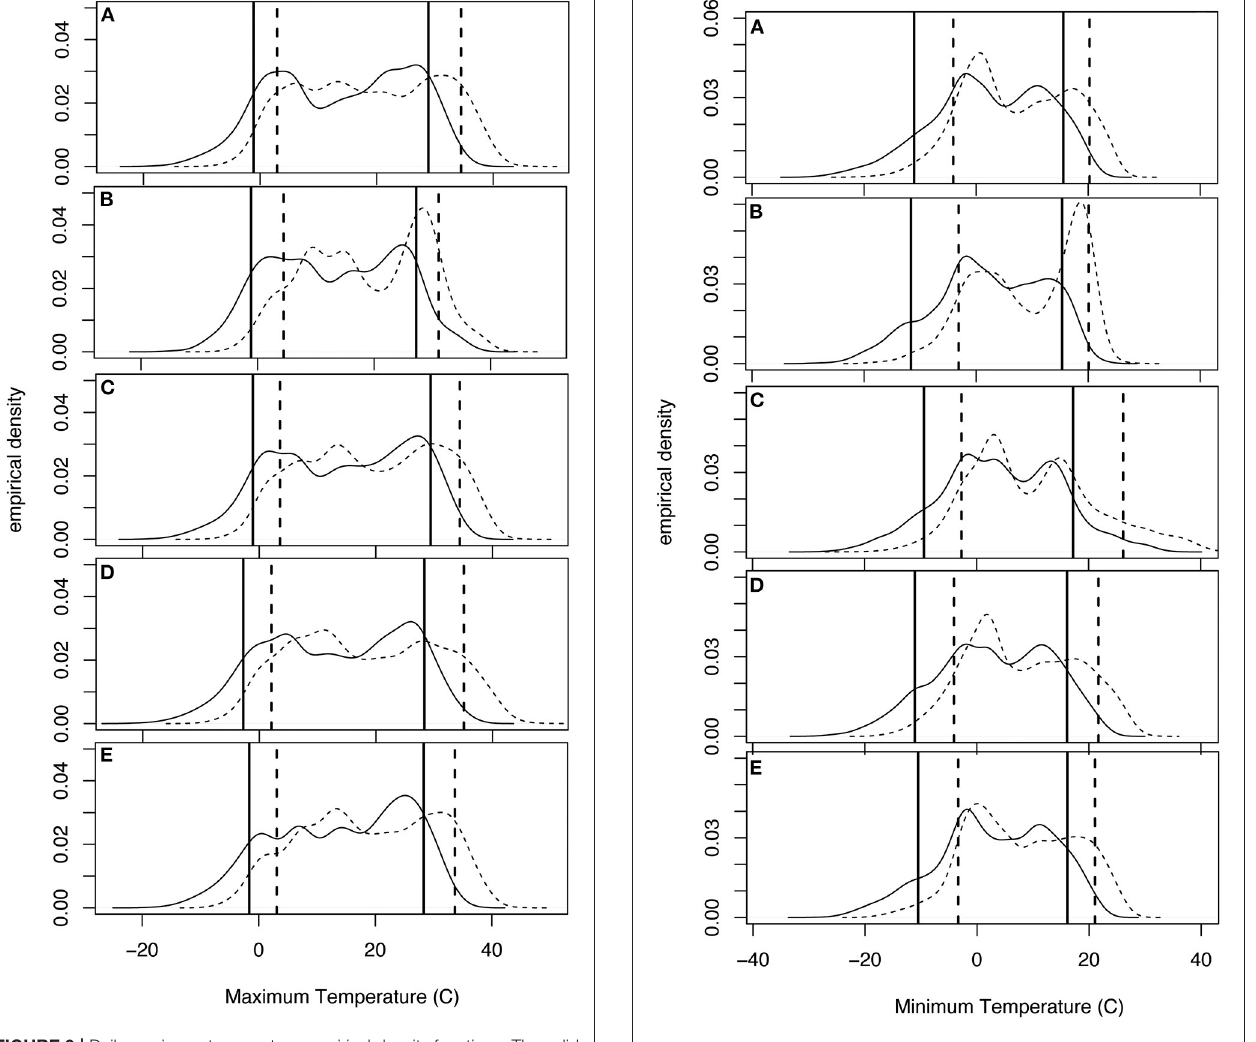
FIGURE 10 | Same as Figure 9 but for daily minimum